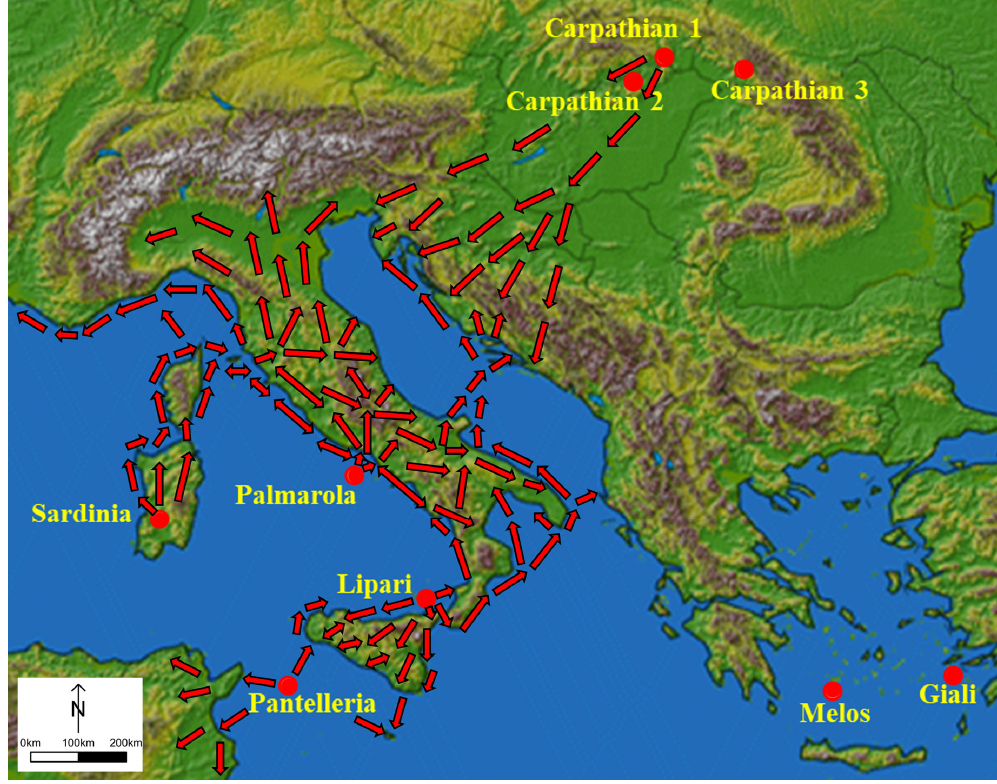
Figure 15. Obsidian distribution directions in the central